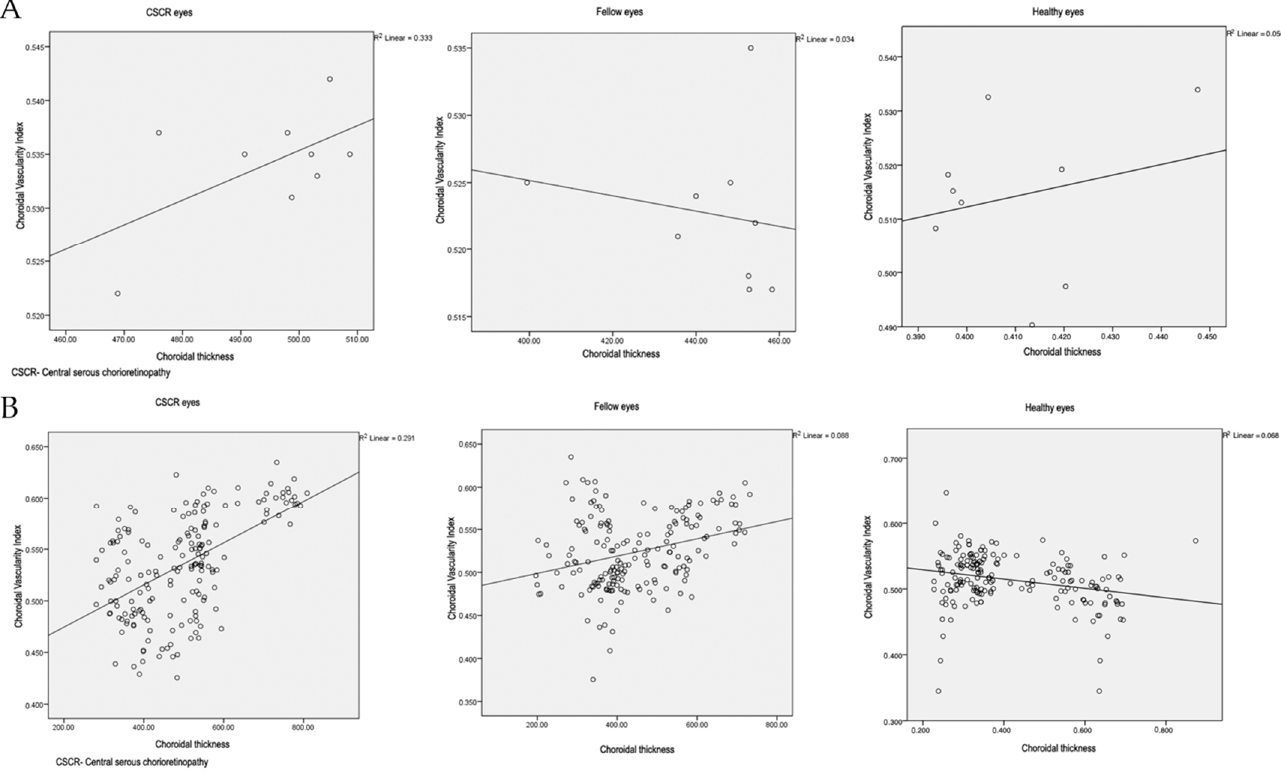
Figure 3. Chart showing the correlation of choroidal vascularity index and choroidal thickness values in the two groups ( A ) Region-wise and ( B ) Overall.